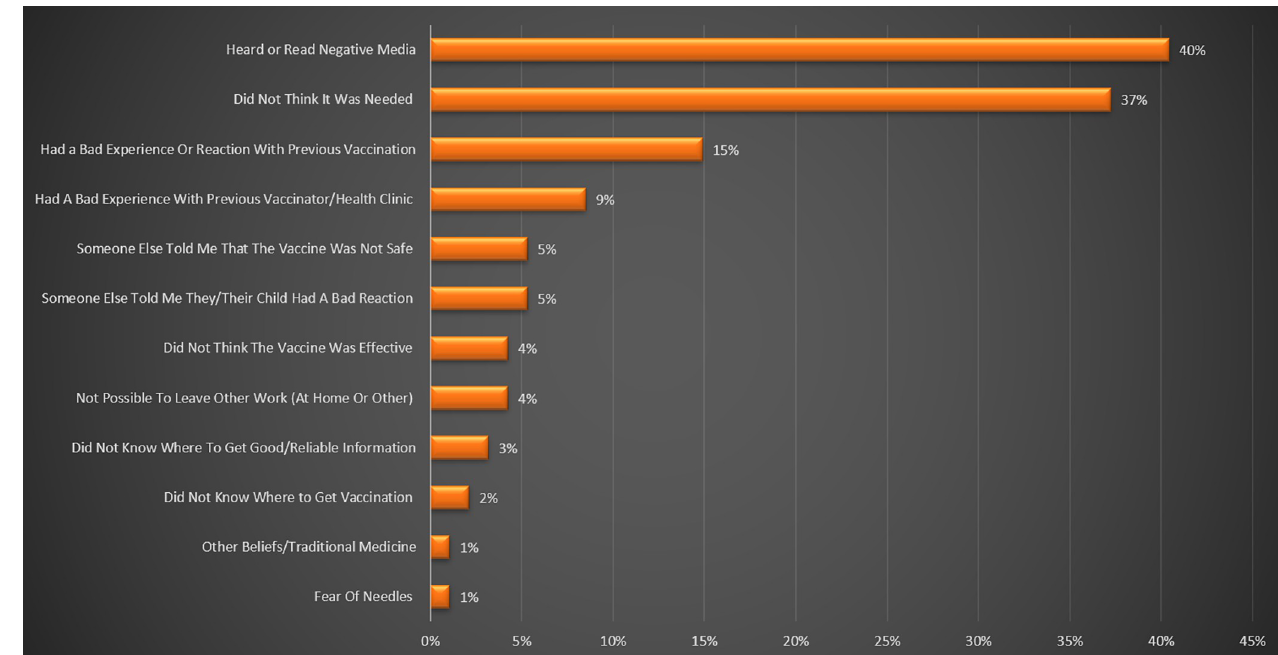
Fig 1. Reasons stated by the parents for refusing one or more vaccines for their children. https://doi.org/10.1371/journal.pgph.0001012.g001 past ( > 8%). In any case, our findings show that lack of trust and confidence, perceived Com- placency (e.g. In Figs 1 & 2, people did not see the need to vaccine their children ) and Conve- nience (e.g. In Figs 1 & 2, few people did not know where to get vaccine ) are the leading causes